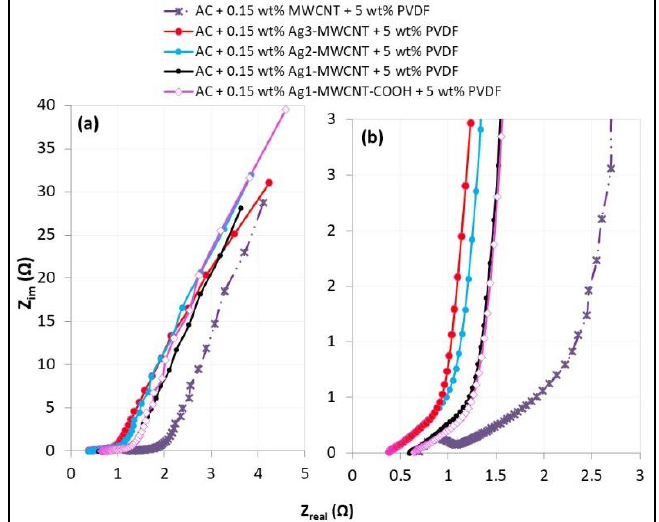
Figure 5. Electrochemical impedance spectroscopy results for the tested electrochemical double layer capacitors (EDLCs) with different types of composite electrode coatings: ( a ) the full Nyquist plot; ( b ) magnified scales near the axes origin.